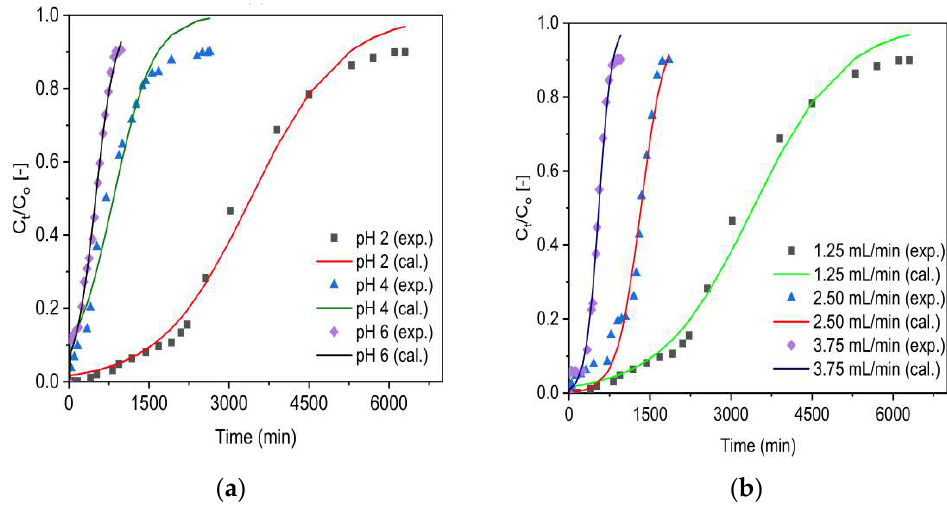
Figure 9. Experimental (exp.) and simulated (cal.; Adams–Bohart model) breakthrough curves of fluoride for ZrOCSc at different ( a ) pH (C O : 10 mg/L; Q O : 1.25 mL/min; bed depth 10 cm) and ( b ) Q O (pH 2; C O : 10 mg/L; bed depth 10 cm). As can be seen from Figures 9 and 10, the breakthrough curves looked to move from right to the left as the pH and inlet flow rate increased from 2 to 6 and 1.25 to 3.75 mL/min, respectively. The Adams–Bohart rate constant (K AB ) and adsorption capacity of the adsor- bents per unit volume of the bed (N O ) predicted by the model are presented in Table 4. Similar to the Thomas model, as the initial flow rate increased from 1.25 to 3.75 mL/min, the maximum volumetric adsorptive capacity of the bed (N O ) decreased from 83 to 40 mg/L for ZrOCSc and 16 to 14 mg/L for VSco. Furthermore, the values of kinetics constant K AB increased and values of EBCT decreased as the flow rate increased. This